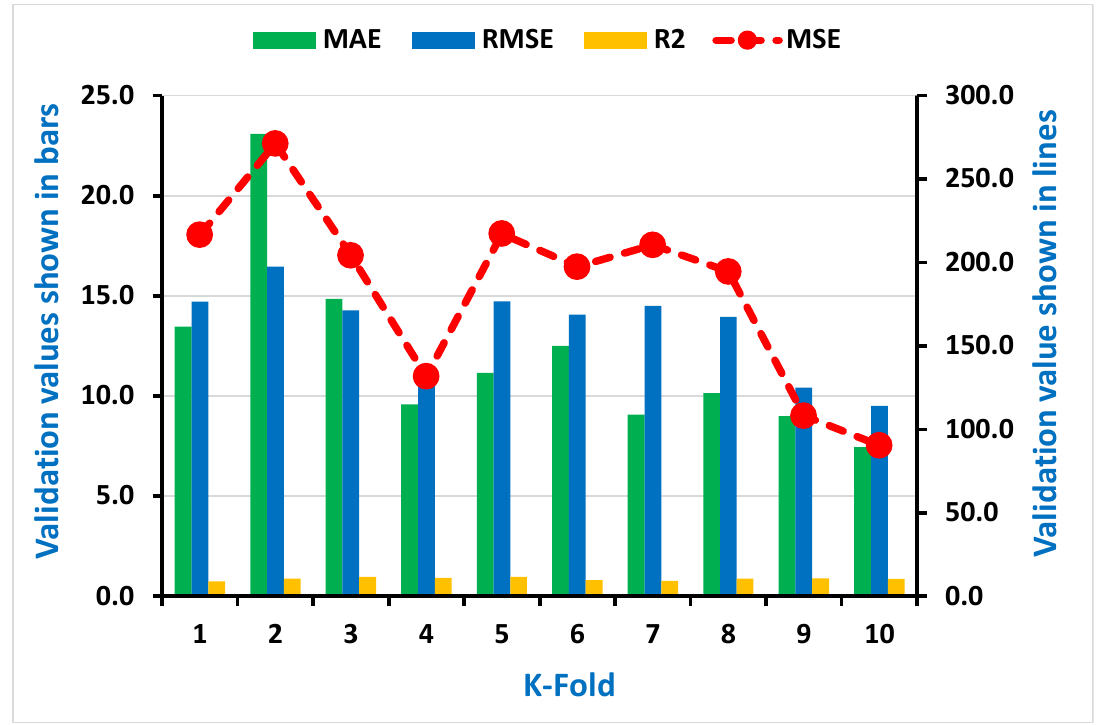
Figure 7. Representation of statistical information of k-fold cross-validation using DT for compressive strength.